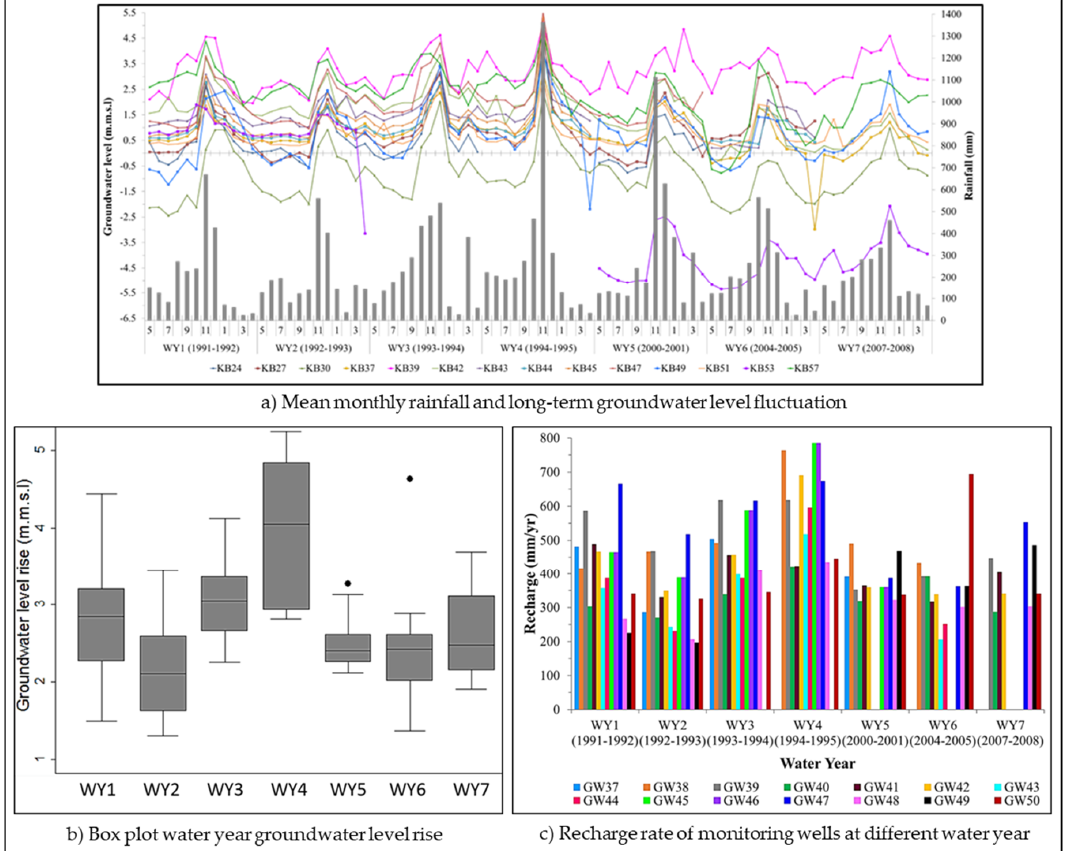
Figure 3. ( a ) Mean monthly rainfall and long-term groundwater level fluctuation; ( b ) box plot water year level rise; and ( c ) recharge rate of monitoring wells at different water year.